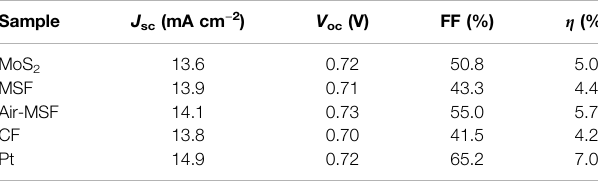
TABLE 1 | Photovoltaic parameters of the cells with air-mesoporous silica nano fi ber (MSF), MSF, CF, MoS 2 , and Pt counter